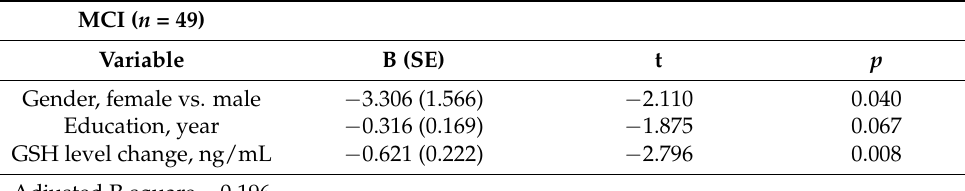
Table 4. Multiple linear regression analyses of independent factors (including GSH level change from baseline to endpoint) associated with cognitive change, measured by ADAS-cog score change from baseline to endpoint, in MCI patients